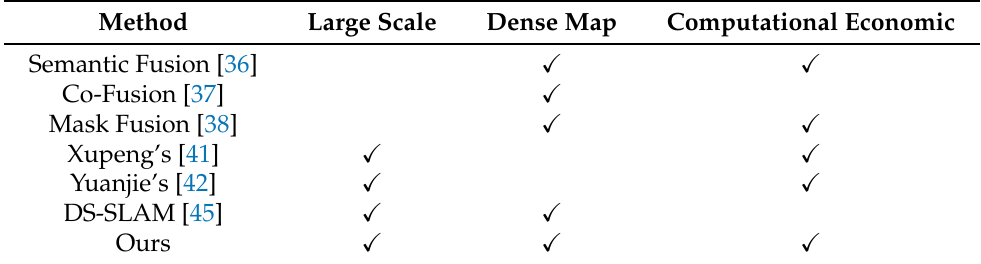
Table 1. Semantic mapping systems related to our system.